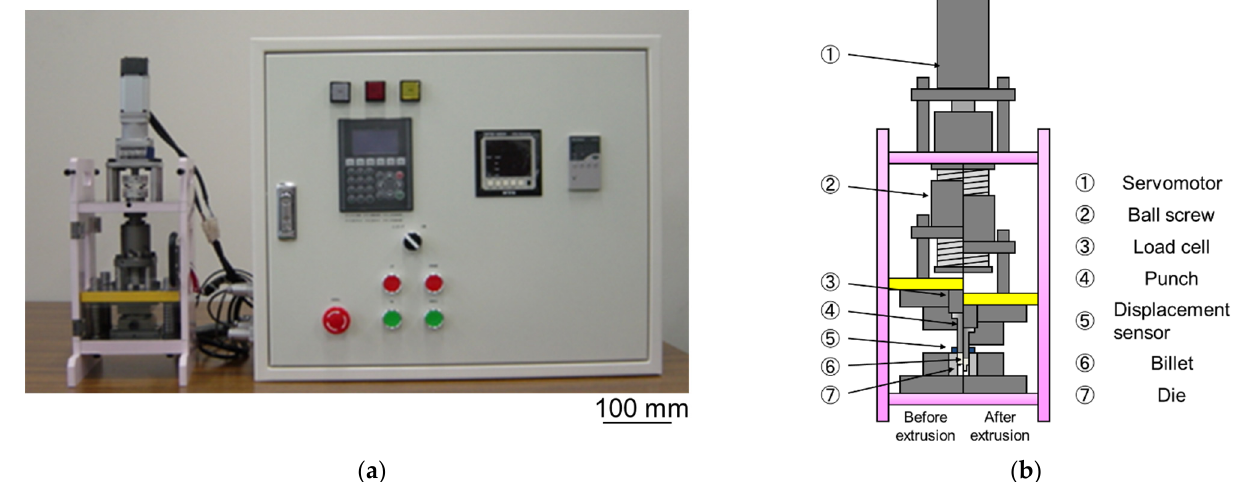
Figure 1. ( a ) Photograph of the experimental setup for microextrusion; and ( b ) schematic diagram of the extrusion apparatus.